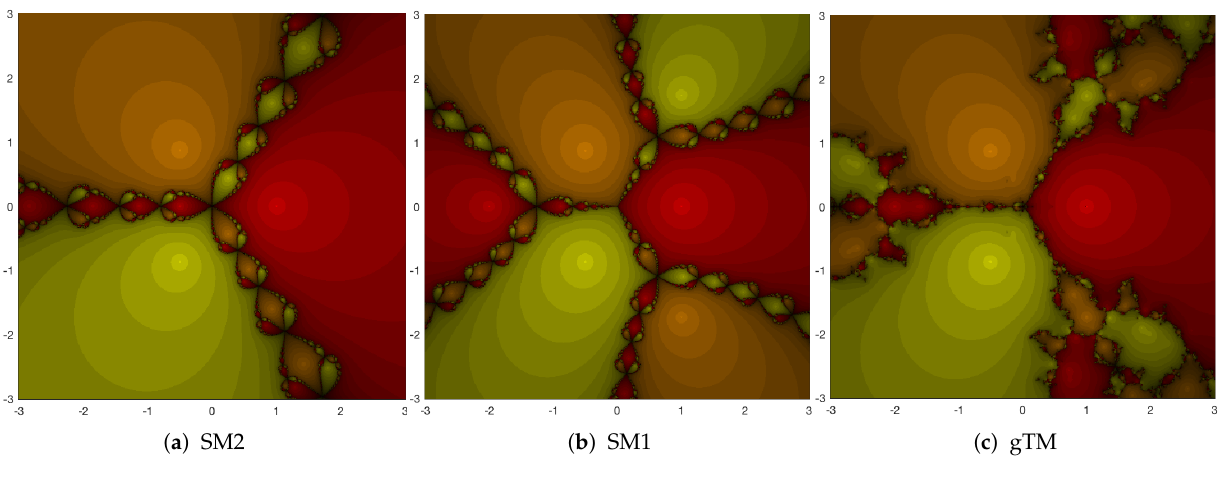
Figure 4. Dynamical planes of Schröder methods and gTM on f 2 ( x ) .